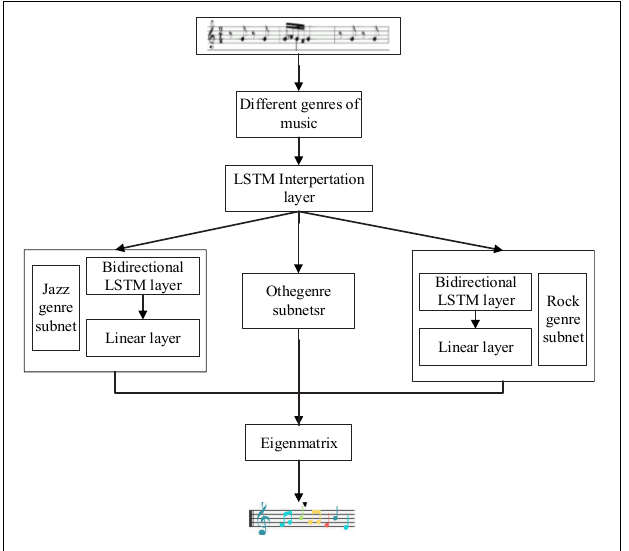
FIGURE 5 | Structure diagram of music style analysis model.